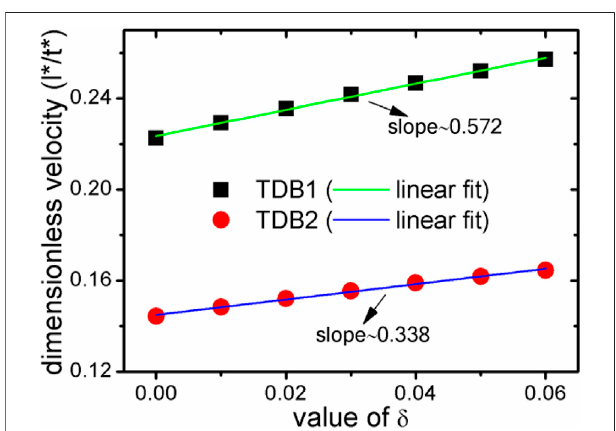
FIGURE 6 | (color online) During the solidi fi cation process of TDB1 at 1800 K, the solid fraction (represented by different line types) and the main radius (represented by different lines + scattered points) under different anisotropic strengths δ over time. Particularly, a subset of solid phase fraction curves are enlarged in the picture.